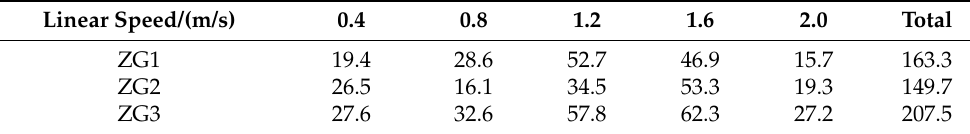
Table 3. Wear mass loss (mg) of design and service materials at different rotational speeds. Linear